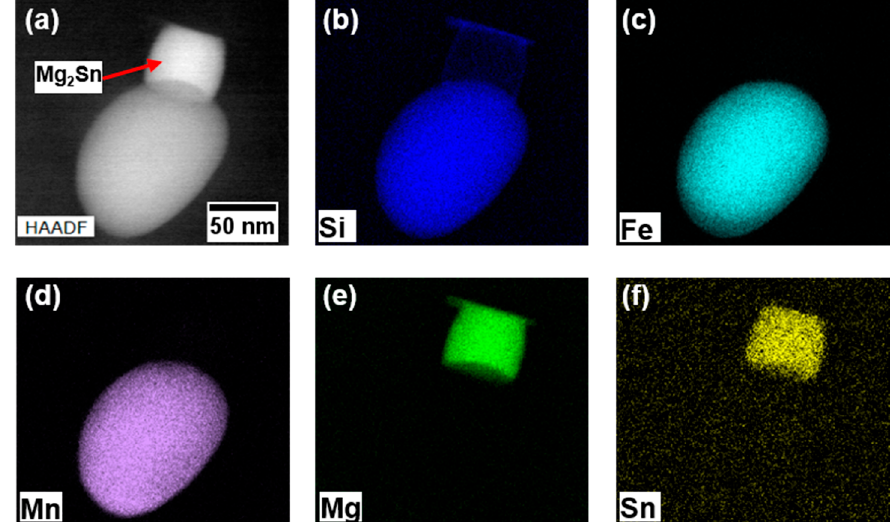
Figure 13. STEM HAADF image of EN-AW-6016 + 100 at.-ppm Sn ( a ) and corresponding EDX mappings of Si ( b ), Fe ( c ), Mn ( d ), Mg ( e ), and Sn ( f ). Mg 2 Sn is precipitated upon air quenching after solution annealing (560 °C) at the incoherent interface of an Al(Fe,Mn)Si-phase.